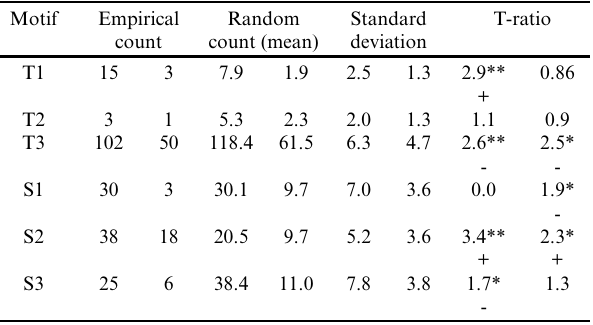
Table 3 . Motif analysis for 1996 and 2009 social-ecological networks. Motifs were compared to 1000 random networks with the same number of links as empirical networks. Statistical significance was based on the actual percentage of random networks that had more/less of the specific motif versus the empirical network. * the fraction is < 0.05; ** the fraction is < 0.01. Plus and minus signs signal whether the motif is overrepresented (+) or underrepresented (-) in